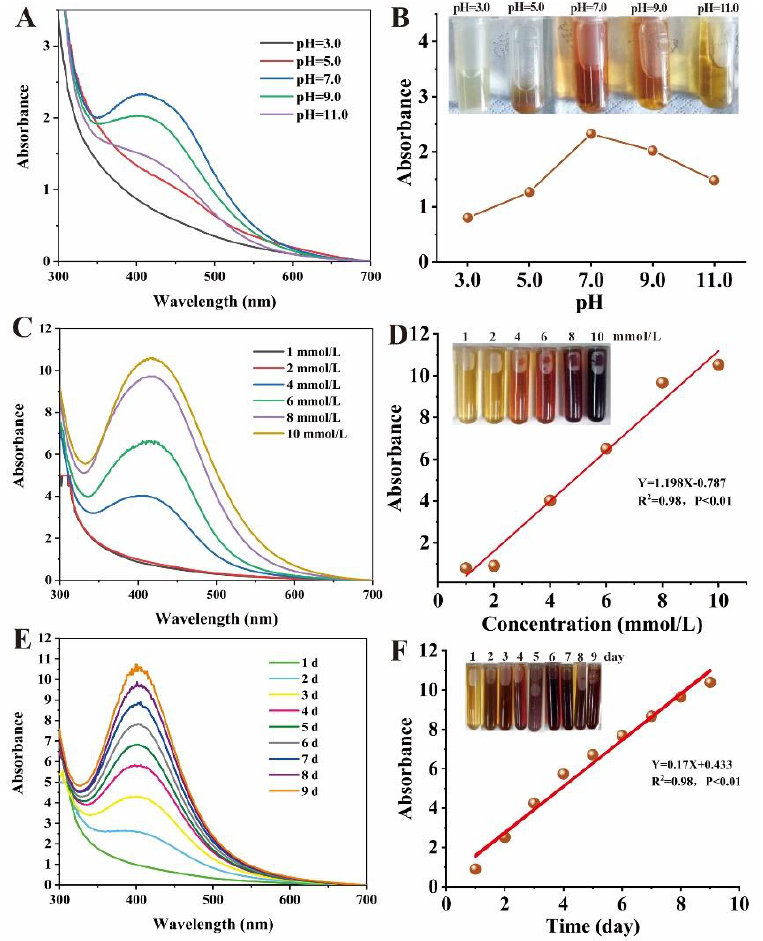
Figure 5. Influence of pH, Ag + concentration and reaction time on nanoparticle synthesis: Uv-vis spectra of reaction system with different pH ( A ), Ag + concentration ( C ) and reaction time ( E ). Digital images and linear graphs of reaction mixtures with different pH ( B ), Ag + concentration ( D ) and reaction time ( F ).